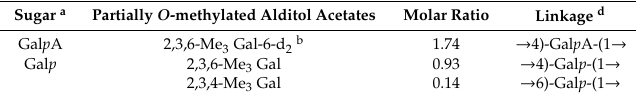
Table 2. Methylation analysis of Houttuynia cordata polysaccharide HP. Sugar a Partially O -methylated Alditol